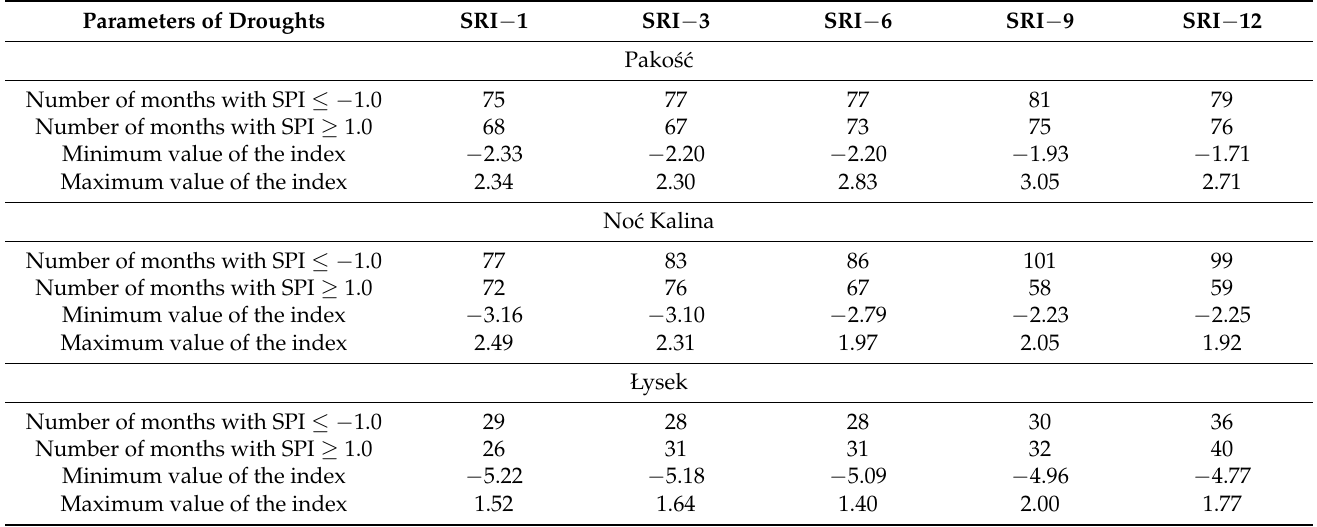
Table 5. The Parameters of a hydrological drought (SRI) in different time scales in the period of 1981–2016. Parameters of Droughts SRI −